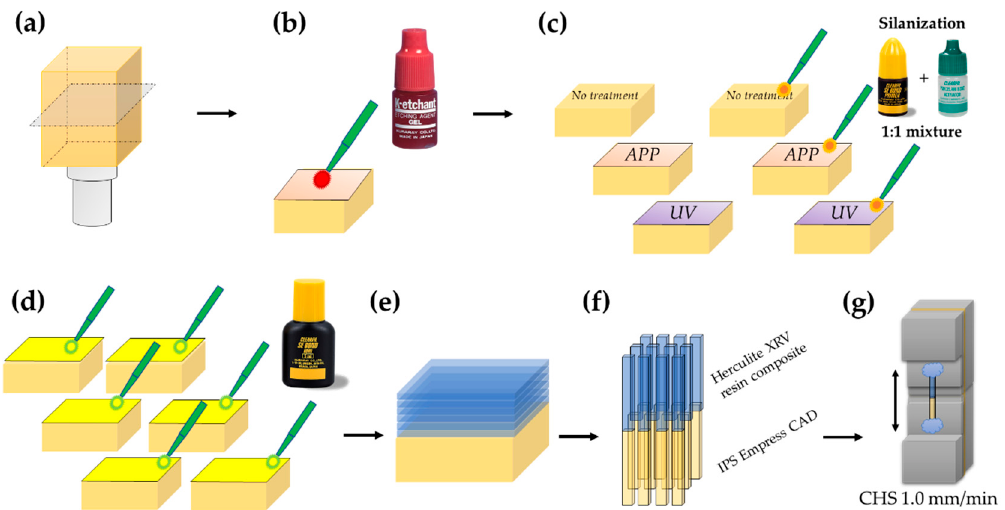
Figure 1. Summary diagram of microtensile bond strength (µTBS) testing. ( a ) IPS Empress CAD was cut into 6 mm-thick slabs; ( b ) After ultrasonically cleaning, each slab was treated with K-etchant GEL; ( c ) Each specimen was assigned into 6 groups; ( d ) The treated surface was coated with Clearfil SE Bond and light-cured and ( e ) built up incrementally with Herculite XRV; ( f ) Resin–ceramic microspecimens (1 mm × 1 mm) were cut with diamond saw and ( g ) they were stressed until failure.